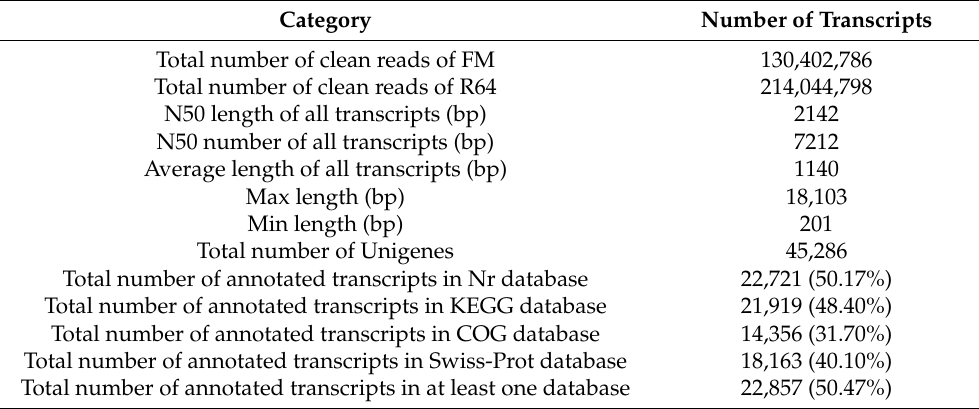
Table 4. Summary of assembly and annotation statistics of the liver transcriptome of S. sihama .